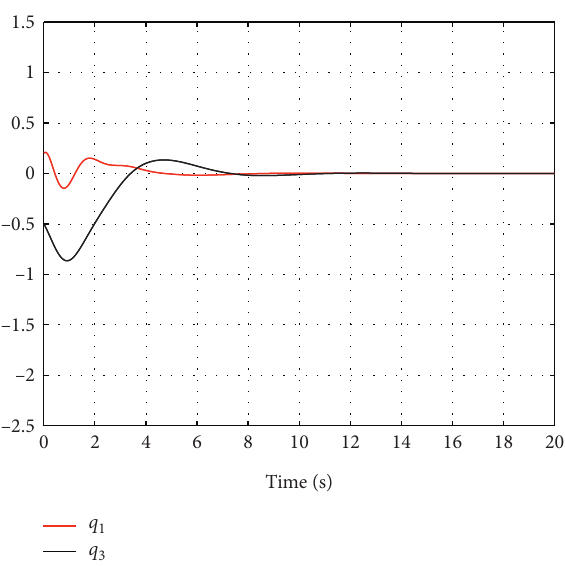
Figure 5: DIP system control effort without